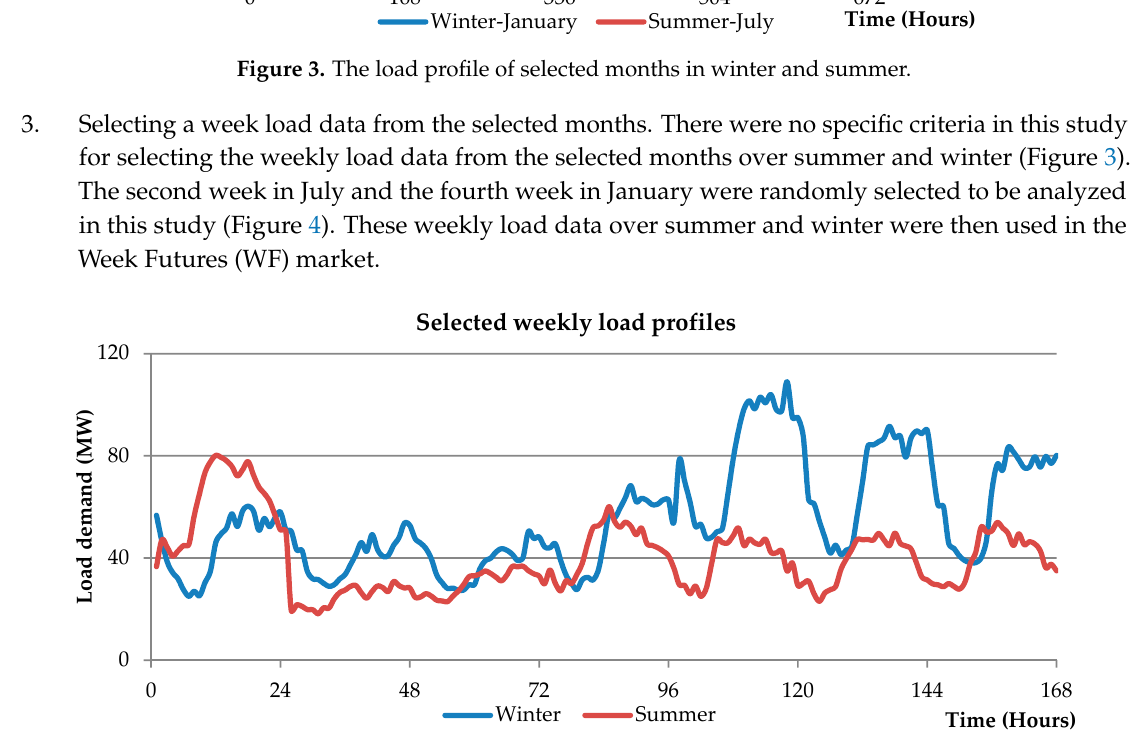
Figure 4. Selected weekly load profiles over summer and over winter for the study.